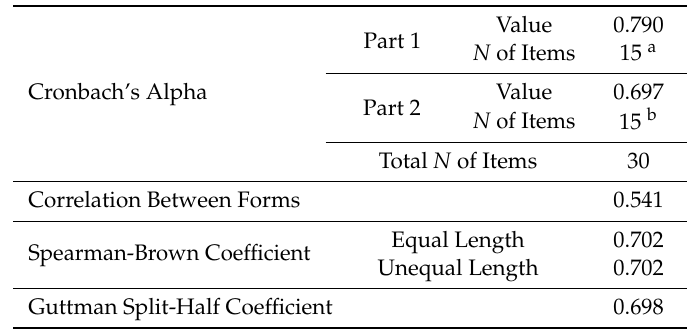
Table 6. Showing reliability statistics in split half